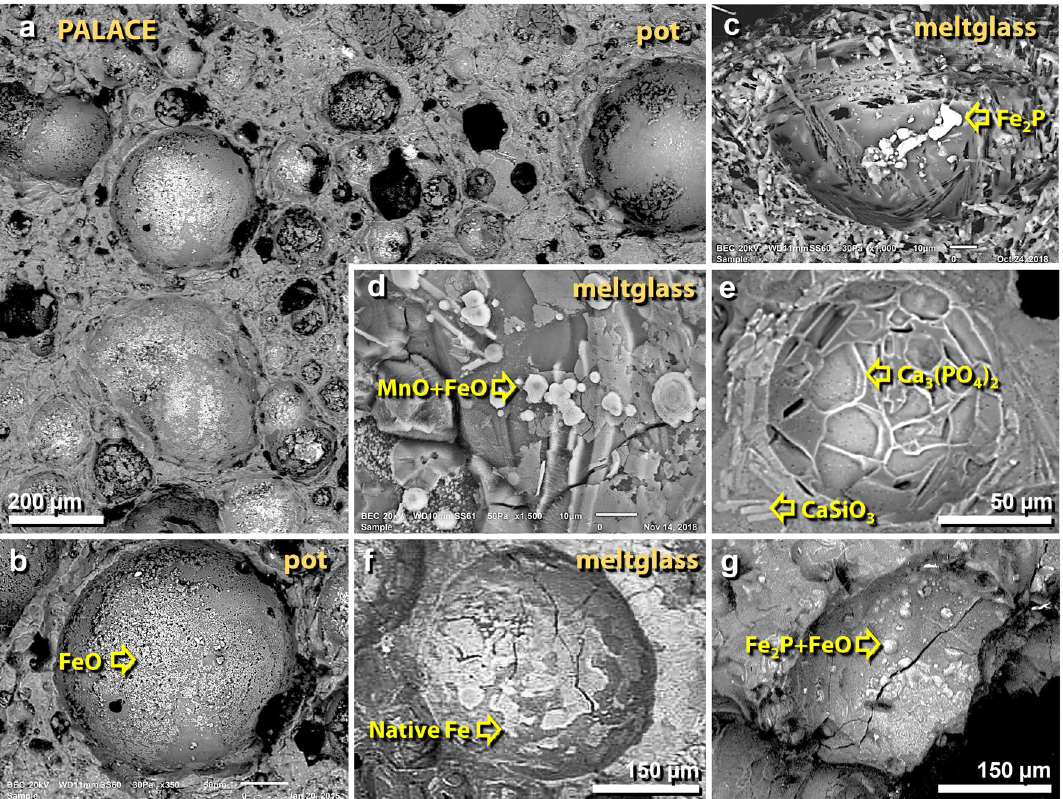
Figure 38. SEM images of gas vesicles in melted material from the palace. ( a ), ( b ) Vesicles in melted pottery are lined with crystals of iron and iron oxide (elemental Fe, Fe 2 O 3 , and/or Fe 3 O 4 ). ( c )–( g ) Vesicles in melted mudbrick and roofing clay often are lined with a variety of crystals including elemental Fe, iron oxide, Fe phosphide (Fe